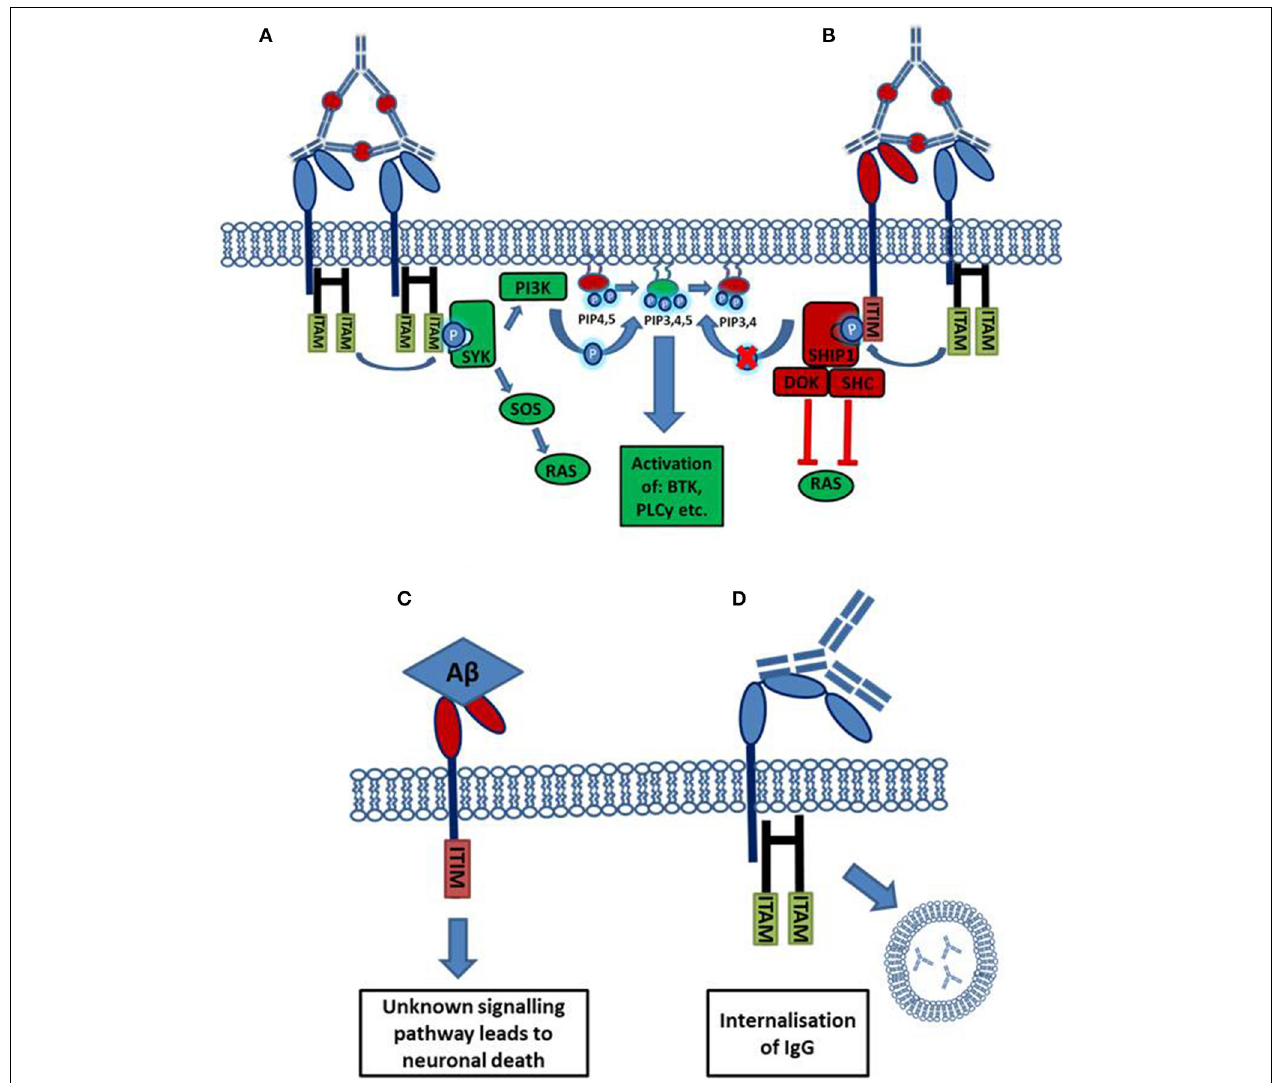
FIGURE 1 | Activation or inhibition of a cell by Fc receptor ligation of IgG immune complexes. (A) Cross linking of activating Fc γ Rs by IgG immune complexes results in the phosphorylation of cytoplasmic ITAM motifs. This allows the recruitment of SH2 domain containing kinases of the SYK family. These kinases activate pathways such as the RAS and PI3K pathways resulting in increased cellular calcium and activation of the cell. (B) The cross linking of an inhibitory receptor to an activating receptor results in the phosphorylation of an ITIM, leading to the recruitment of the phosphatase